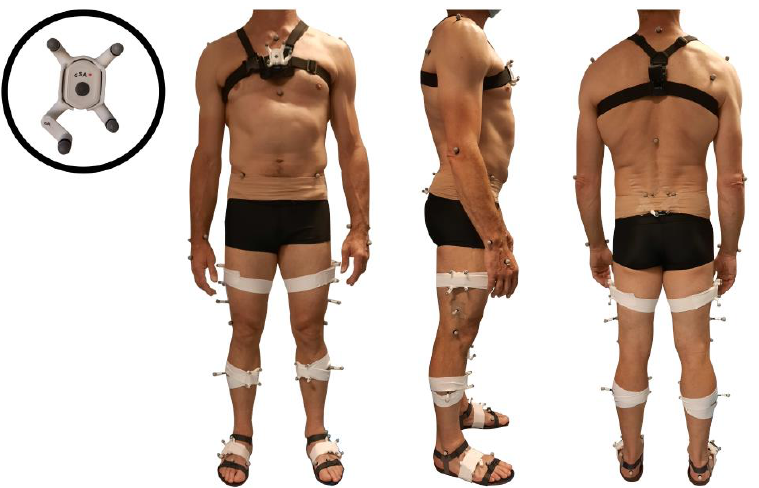
Figure 1. Equipment including 7 inertial sensors (Physilog6S, GaitUp) and reflective markers on the clusters and body landmarks (Conventional Gait Model